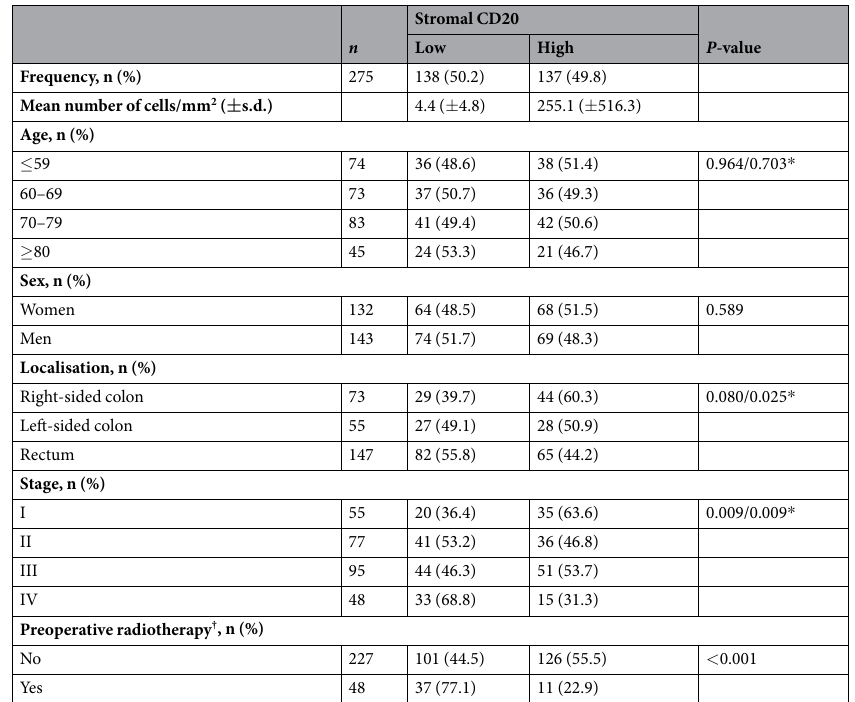
Table 1. Associations to clinicopathological characteristics. χ 2 tests were used for categorical variables. * Exact linear-by-linear association test was used to test for linear relationship between variables. † Preoperative radiation therapy in rectal cancers only.